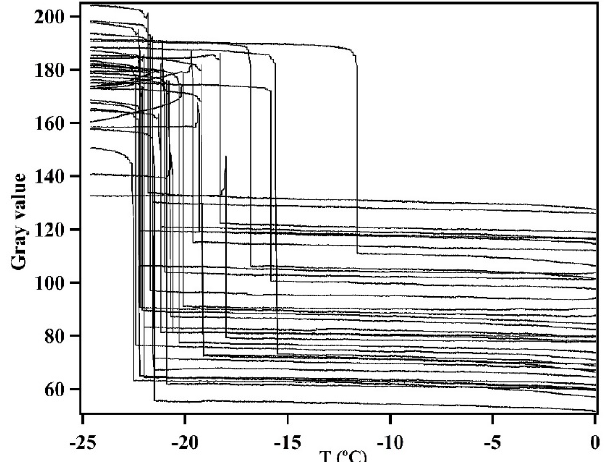
Figure A1. Gray value changes of different droplets in different temperatures.